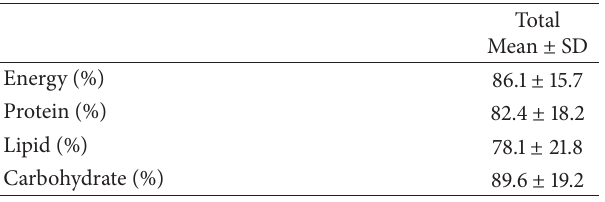
Table 4: Intake (%) of energy and each nutrient in patients with MAC lung disease.